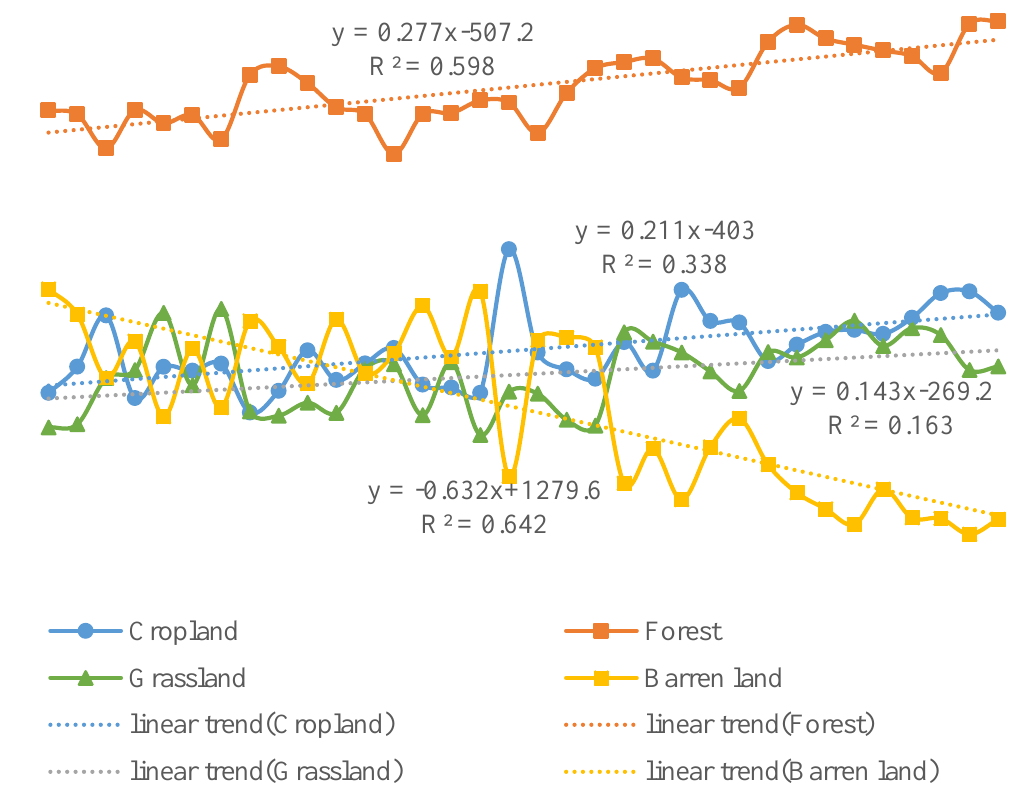
Figure 16. The trends of area proportion changes for each landcover type during 1982–2015. From the perspective of spatial distribution, the barren land in Shaanxi Province was mainly concentrated in Northern Shaanxi (Figure 17). The central region of Shaanxi Province was dominated by crop land. The southern area of Shaanxi was dominated by forest land. In the time series, among the four land use types, the barren land and forest land area obviously fluctuated with time. In 1982, the area of barren land was the largest. In 1986, the area of this land type in Northern Shaanxi decreased sharply and the grassland area increased. By 1989, the barren land area increased, but decreased rapidly in 1998. Since 2002, the area of barren land had gradually